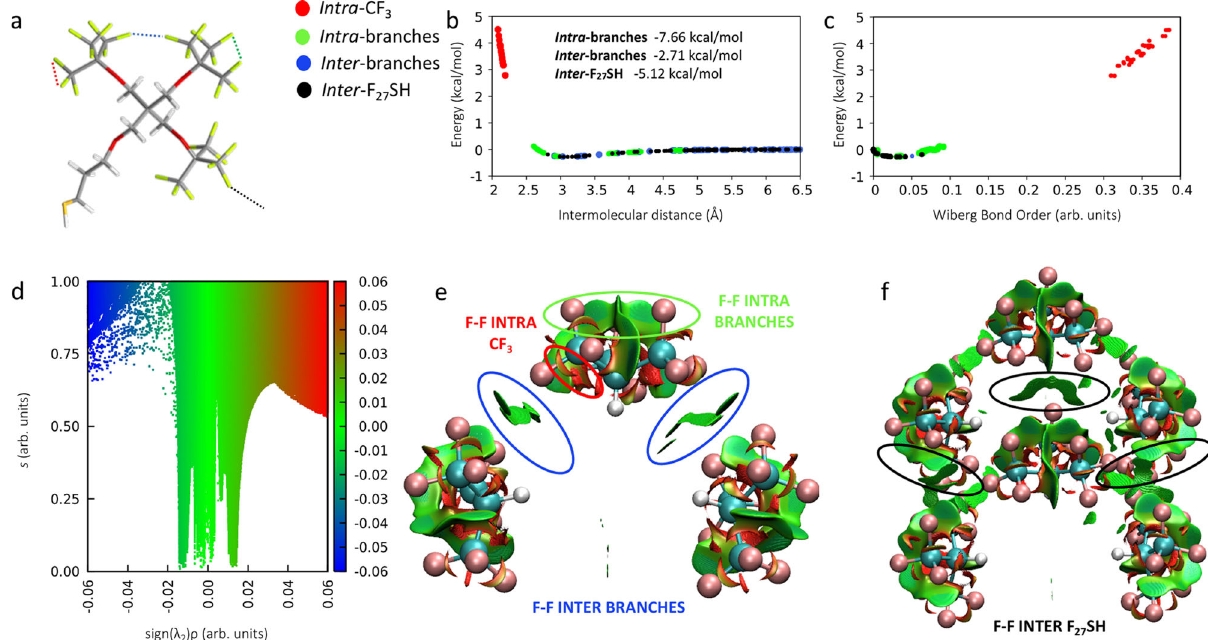
Fig. 1 DFT characterization of F···F interactions in the F 27 SH crystal structure. a Molecular structure of F 27 SH and graphical representation of intra - and inter -molecular F···F interactions in F 27 SH. Atom color code: C, gray; O, red; F, light yellow; S, dark yellow and H, white. F···F interactions color code: red, intra -CF intra -branches; blue, inter -branches; and black, F···F inter -F 3 ; green, F···F 27 SH; b , c F···F intermolecular interaction energy calculated at M062x/aug- cc-pvtz level of theory with GD3 Grimme ’ s empirical dispersion corrections and Wiberg bond orders; the inset of b reports the total interacting energy (kcal/mol) for every F···F interacting pair; d non-covalent interactions map calculated at the same level of theory of b and c showing intra and inter non- covalent interacting regions between the branches of two nearby thiol molecules. The reduced density gradient is plotted versus the sign of the second density Hessian eigenvalue multiplied by the density itself (sign( λ 2 ) ρ ); the conventional color code applied uses blue to indicate attractive (negative values of sign( λ 2 ) ρ ) interactions, red for repulsive (positive values of sign( λ 2 ) ρ ) interactions and green for weak van der Waals interactions (sign( λ 2 ) ρ close to zero); e , f three-dimensional iso-surface plots of non-covalent interactions (isovalue 0.8) calculated in a single thiol molecule and in two nearby thiols visualizing interactions as green surfaces for weak van der Waals, red surfaces for non-bonding repulsive steric interactions. Red, green, blue, and black colors correspond to the classi fi cation of F···F interactions indicated in this work.